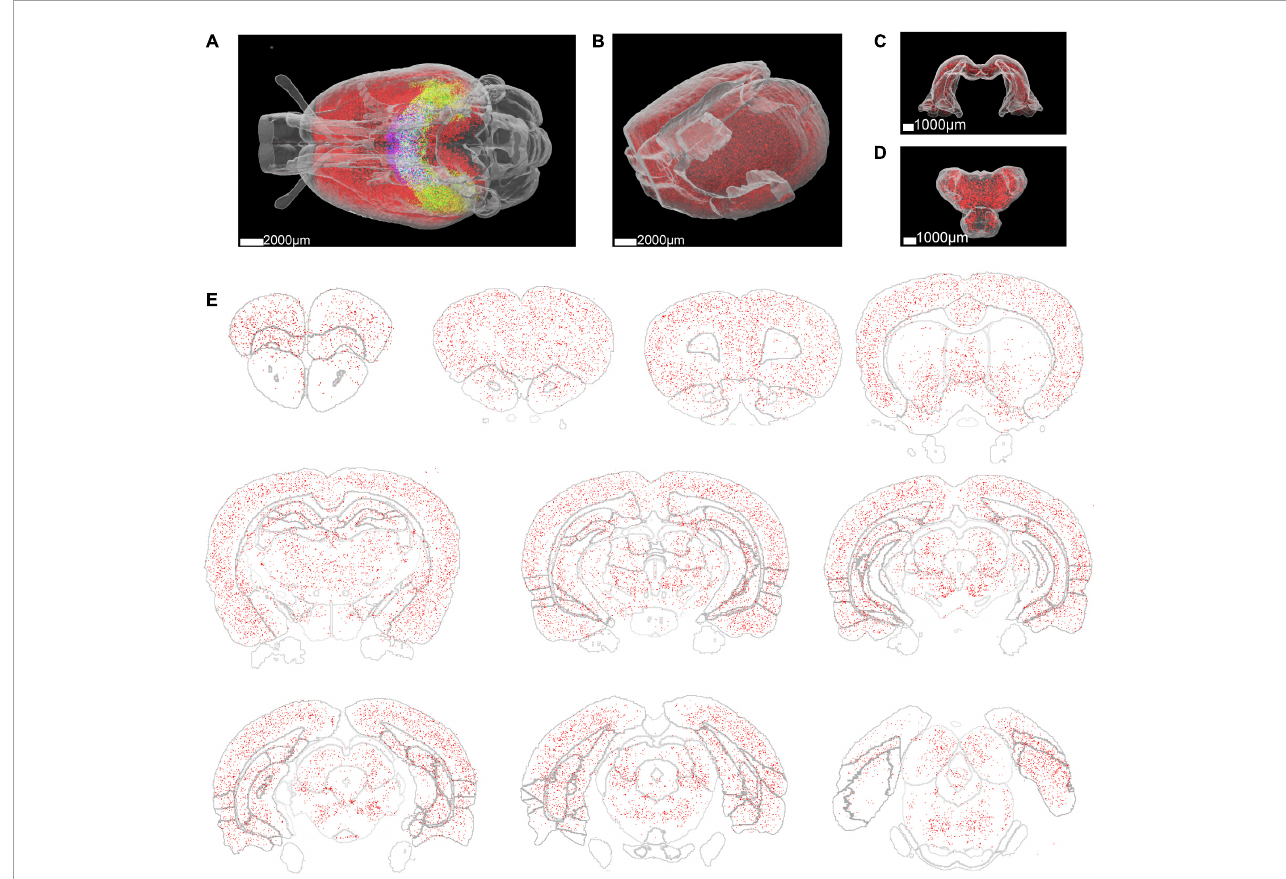
FIGURE4 Whole rat brain rendering of segmented A β plaques. (A) The A β plaque distribution in the whole brain of a 3-month-old rat. Different colors represent the A β plaque distribution in different brain regions. Red: cortex, green: hippocampus, blue: thalamus. (B–D) Enlarged view of the A β plaque distribution in the cortex, hippocampus, and thalamus. (E) A β plaque distribution in 300 µ m thick brain slices at different coronal